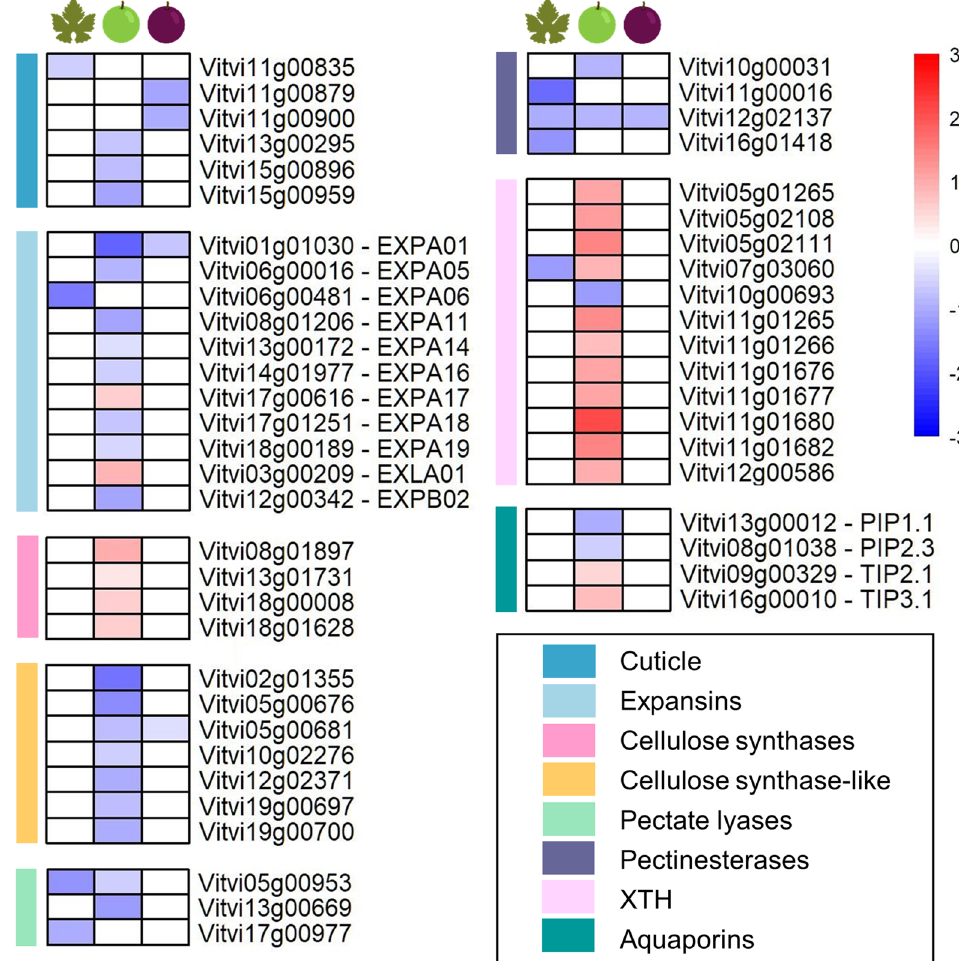
Plant terpenoids are synthesised via the cytosolic MVA and the plastidial MEP pathways. In the MVA, one acetyl-CoA acetyltransferase ( VviAACT ) was down-regulated in ozonated BR, while a hydroxymethylglutaryl- CoA reductase ( VviHMGR ) was up-regulated. In the MEP, the genes encoding a 1-deoxy-D-xylulose-5-phosphate synthase ( VviDXS ), a geranylgeranyl pyrophosphate synthase ( VviGGPPS ), and a terpene synthase ( VviTPS31) were down-regulated in BR. Several genes of the phenylpropanoid and flavonoid pathway were also differentially expressed by OW. In particular, two phenylalanine ammonia-lyases ( VviPAL ) and one trans-cinnamate-4-monooxygenase ( VviC4H ) were down-regulated in BR. In contrast, three caffeic acid 3-O-methyltransferases ( VviCOMT ) were differentially regulated with two genes down-regulated and one up-regulated. Other genes involved in the terminal steps of monolignol biosynthesis were also affected; namely, a cinnamoyl-CoA reductase ( VviCCR ) was down-regulated, while a cinnamyl alcohol dehydrogenase ( VviCAD ) up-regulated. In the same berries, two isoflavone reductases ( VviIFR ), implicated in the isoflavonoid phytoalexin branch pathway, were down-regulated. Lastly, the ozonation of MR berries only reduced the expression of a hydroxycinnamoyl-CoA: shikimate / quinate hydroxycinnamoyl- transferase ( VviHCT ) and a VviIFR . Regarding the flavonoid pathway, a flavanone 3-hydroxylase ( VviF3H ), a flavonoid 3 ′ -hydroxylase ( VviF3 ′ Ha ) and a leucoanthocyanidin dioxygenase ( VviLDOX ) were modulated by the stress in BR: the first one up-regulated, while the last two down-regulated. A caffeoyl shikimate esterase ( VviCSE ) and the VviF3 ′ Ha were the only DEGs down-regulated in L. Lastly, relevant transcription factors, such as VviMYB5a , VviMYB5b , and VviMYBF1, controlling different branches of the flavonoid pathway, were down-regulated in BR.